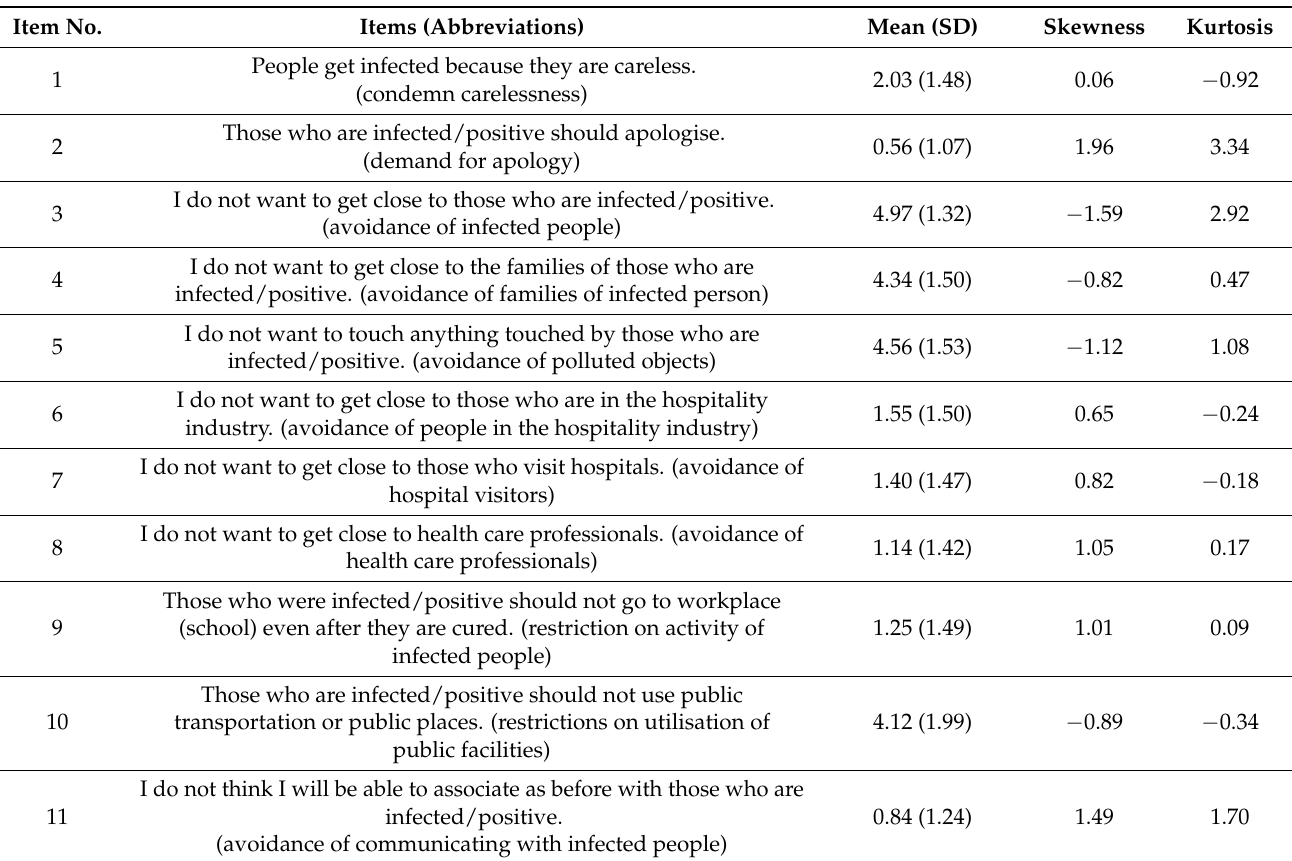
Table 2. Mean, SD, skewness, kurtosis of the COVID-19 stigma scale items ( n =